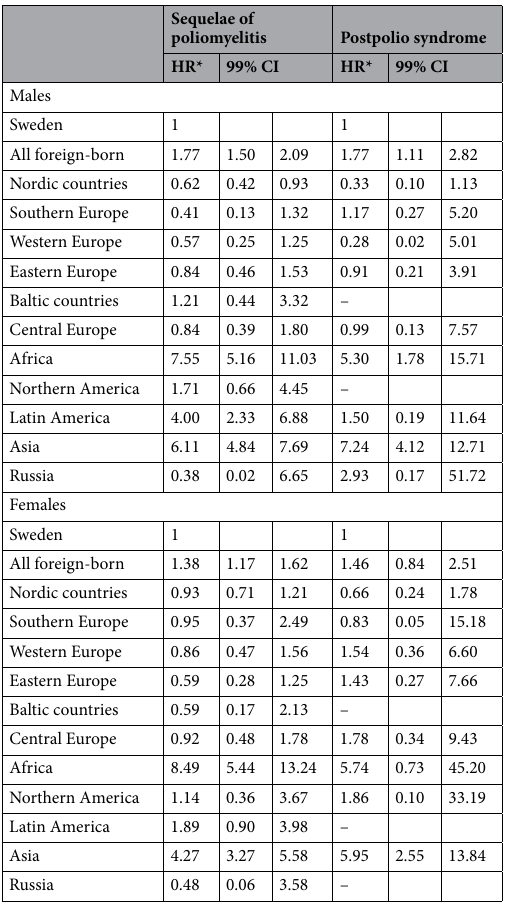
Table 4. The relative risk of post-polio in immigrants vs Swedish-born individuals categorized into sequelae or post-polio syndrome expressed as hazard ratios (HRs) with 99% confidence intervals (99% CI). Bold values denotes statistically significant values. *Fully